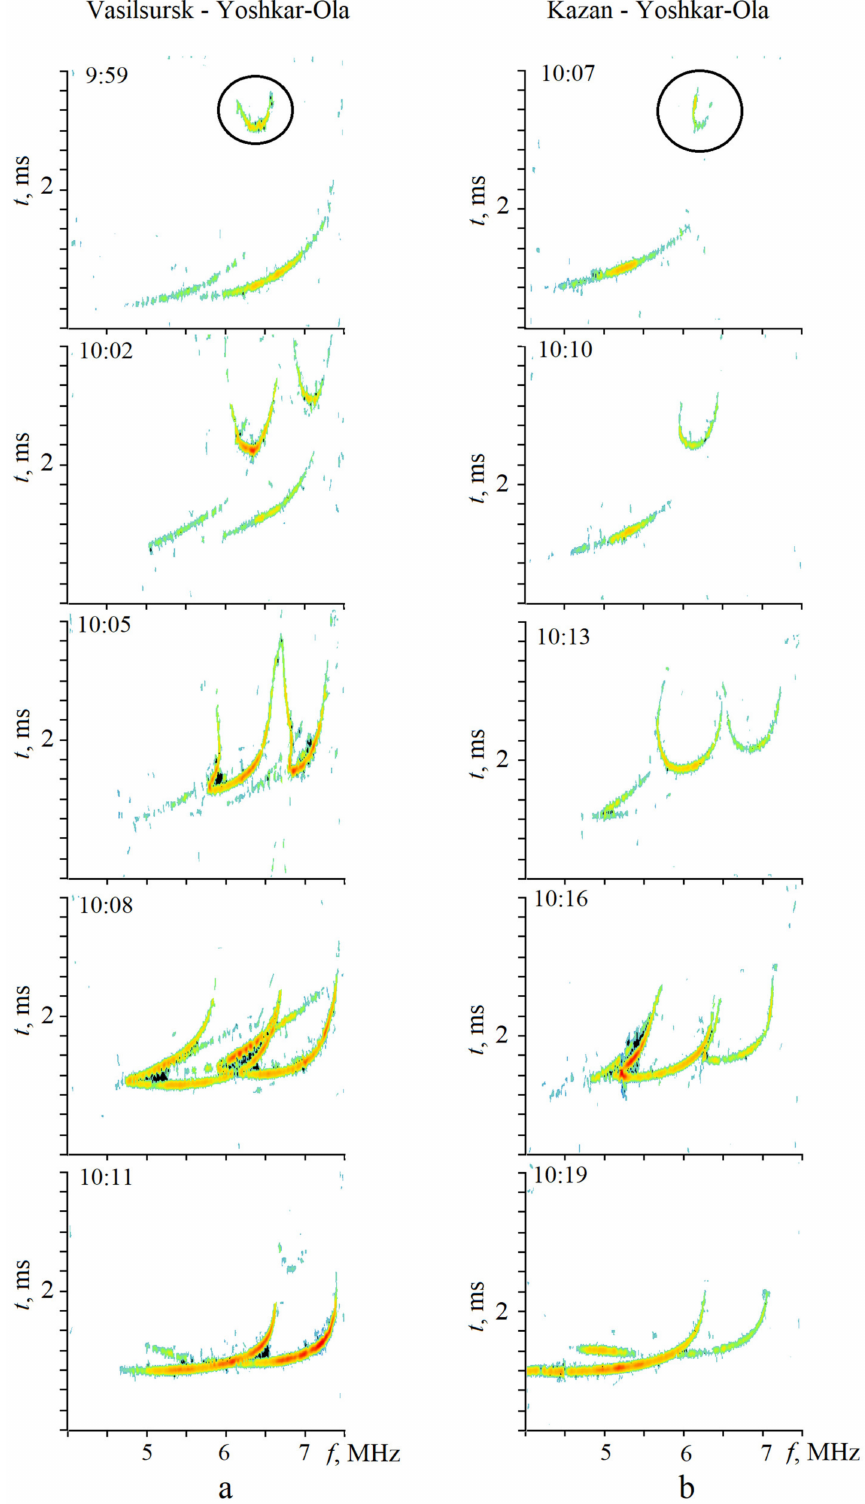
Figure 7. Ionograms for Vasilsursk-Yoshkar-Ola ( a ) and Kazan-Yoshkar-Ola ( b ) on 19 December